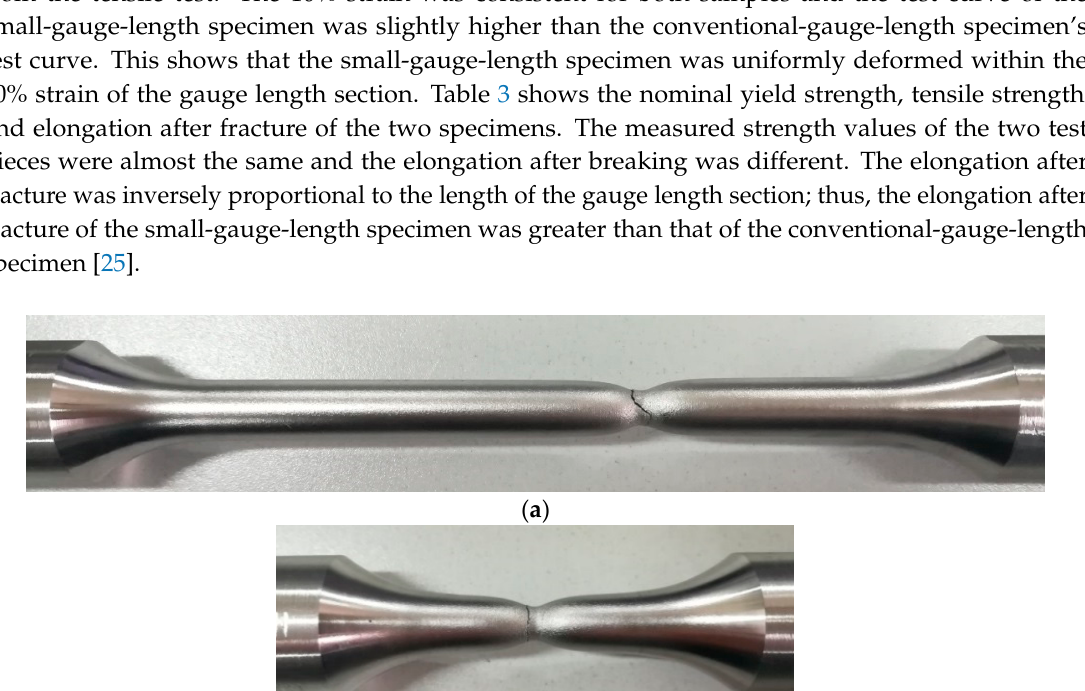
Figure 4. Arrangement of the extensometer.